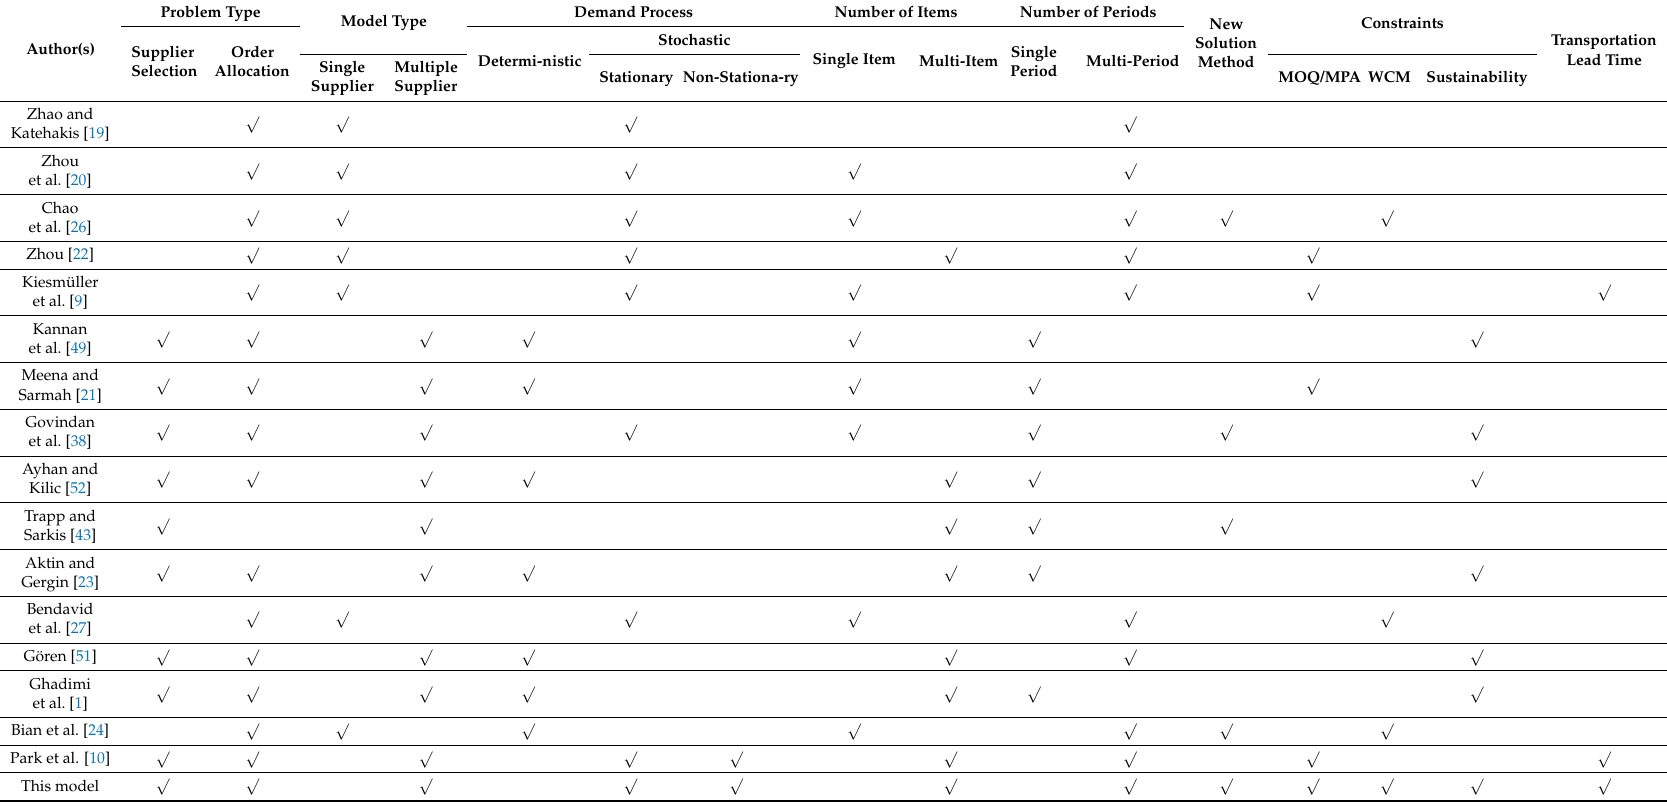
Table 1. Comparison of the contributions of different